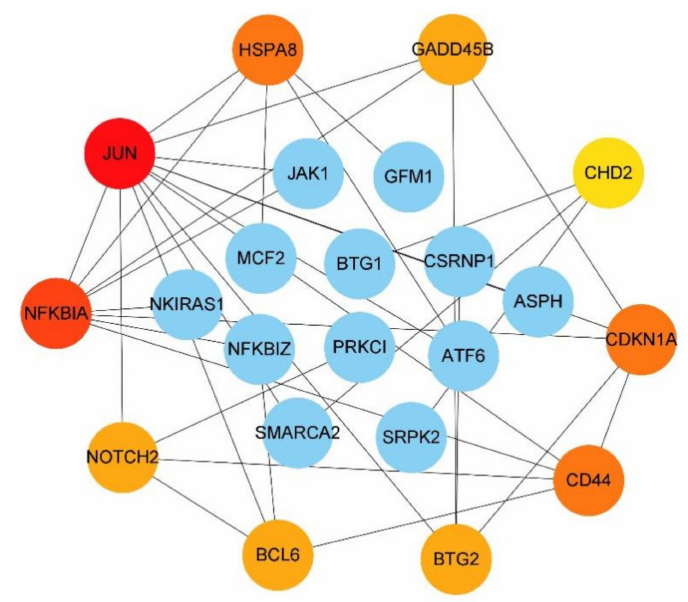
Figure 6. Protein–protein interaction network constructed with 10 hub genes and other DEGs. The darker the gene, the more prominent the core position in the network.